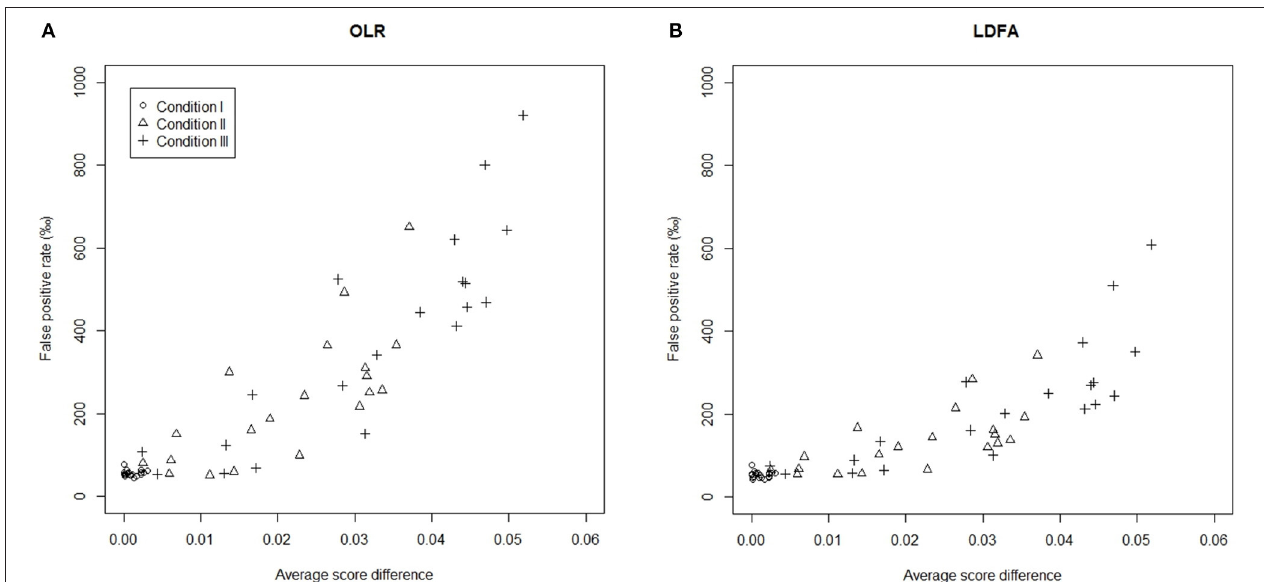
FIGURE 2 | Relationships between the average score difference (in absolute value) and the false positive rate in a 20-item test. (A) OLR and (B) LDFA. Conditions I, II, and III denote that the mean differences in the magnitude ofERS were set at 0, 0.4, and 0.6, respectively.